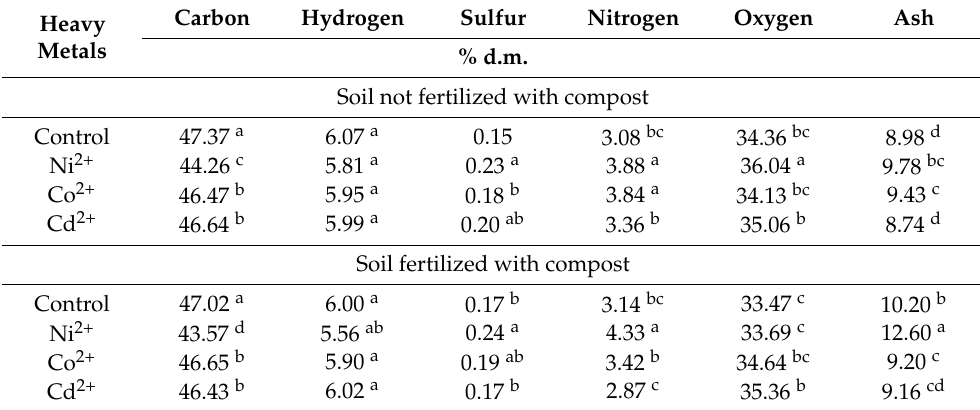
Table 4. Elemental composition and ash content of Festuca rubra